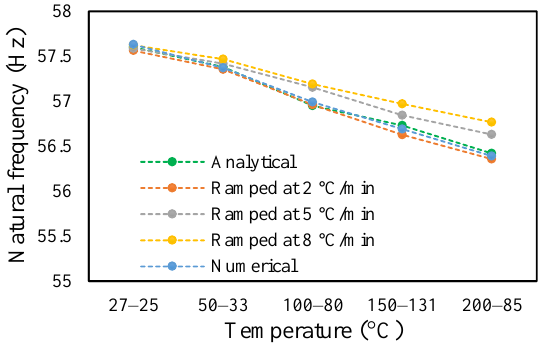
Figure 12. Natural frequency of 0.25 mm crack depth in non-uniform temperature.